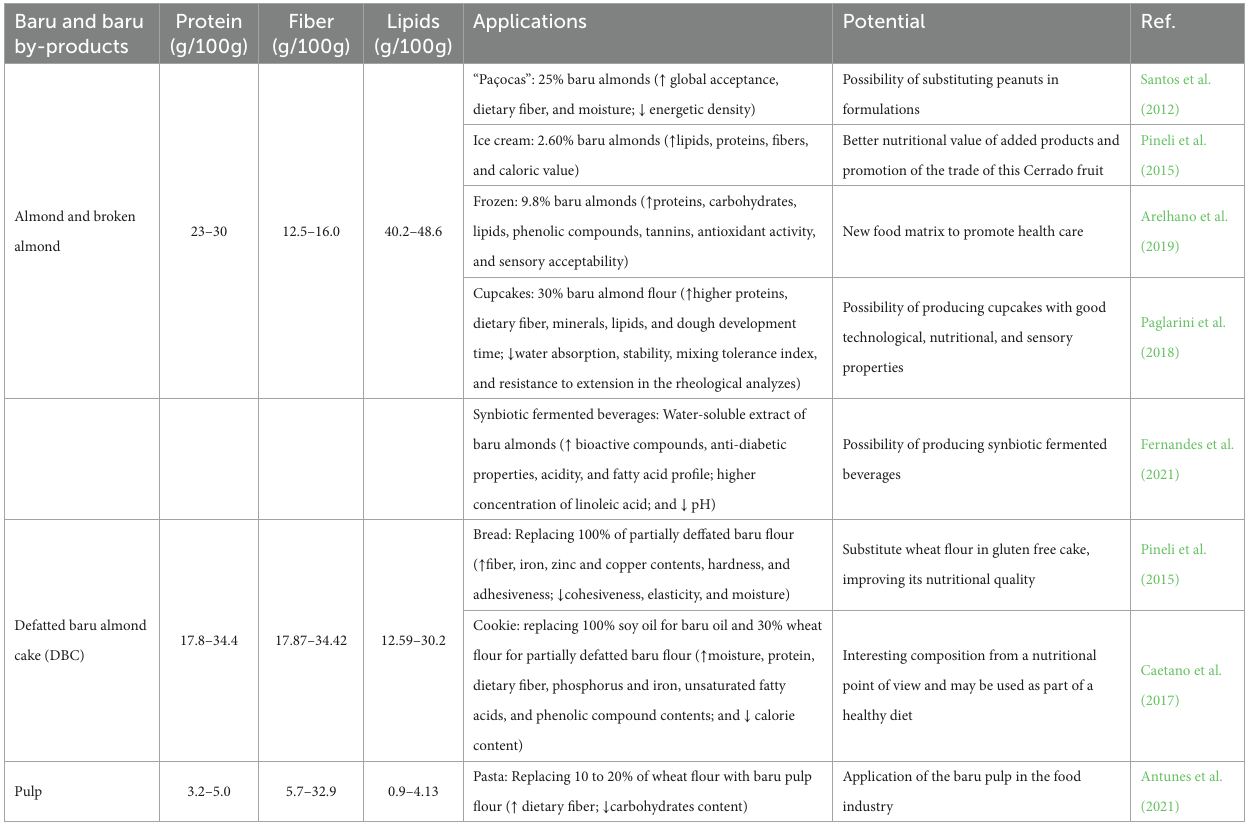
Possibility of producing cupcakes with good technological, nutritional, and sensory Application of the baru pulp in the